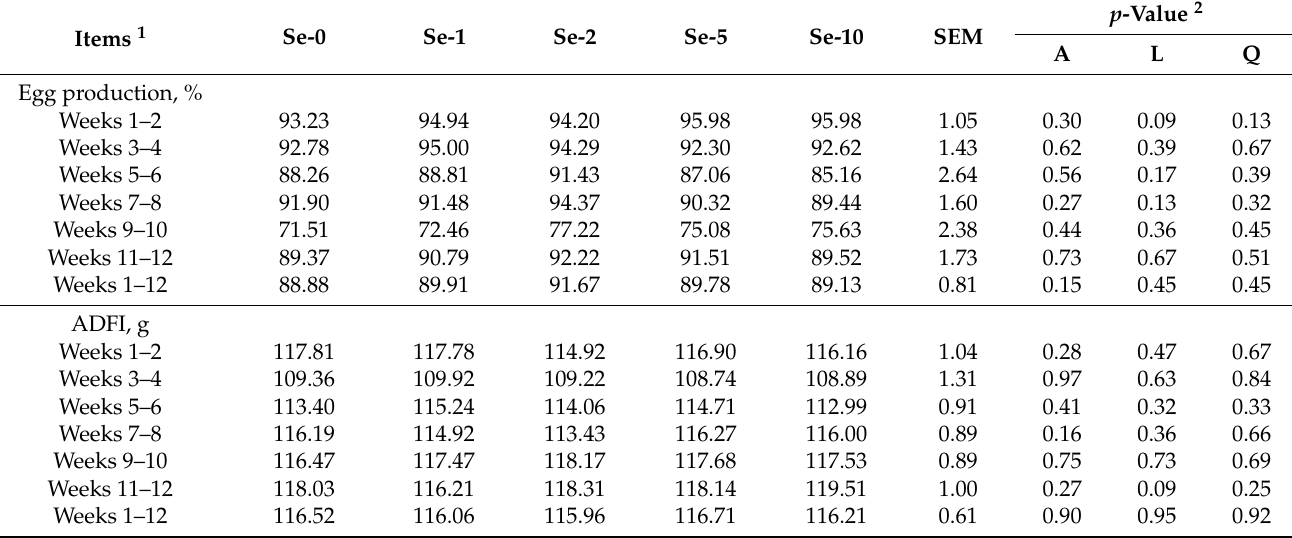
Table 3. Effects of dietary organic selenium on performance in laying